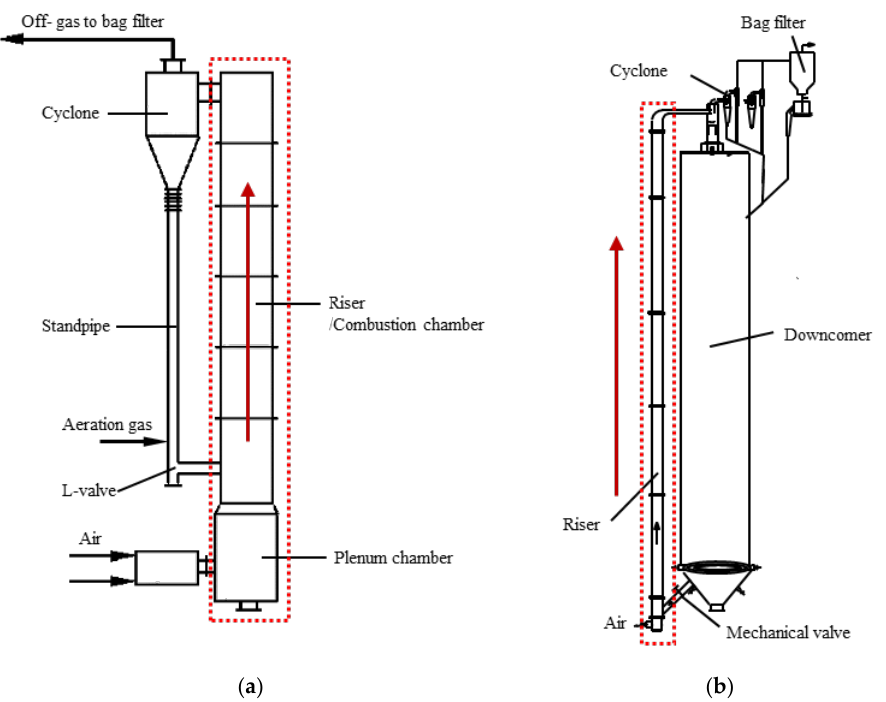
Figure 1. Two typical circulating fluidized bed (CFB) setups. ( a ) Experiment CFB setup for Circulating fluidized bed combustor system, ( b ) experiment CFB setup for Fluid catalytic cracking system.